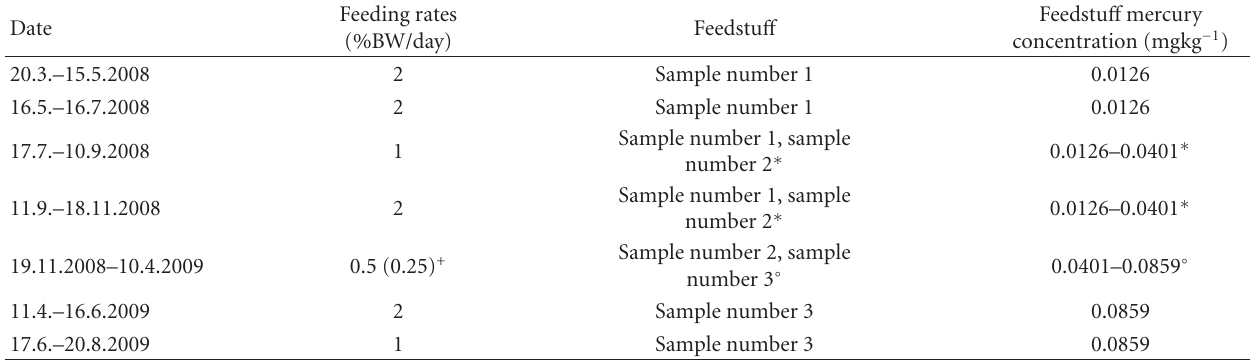
Table 3: Feeding rates (percent of body weight per day) and feedstu ff types during the sampling period. Date